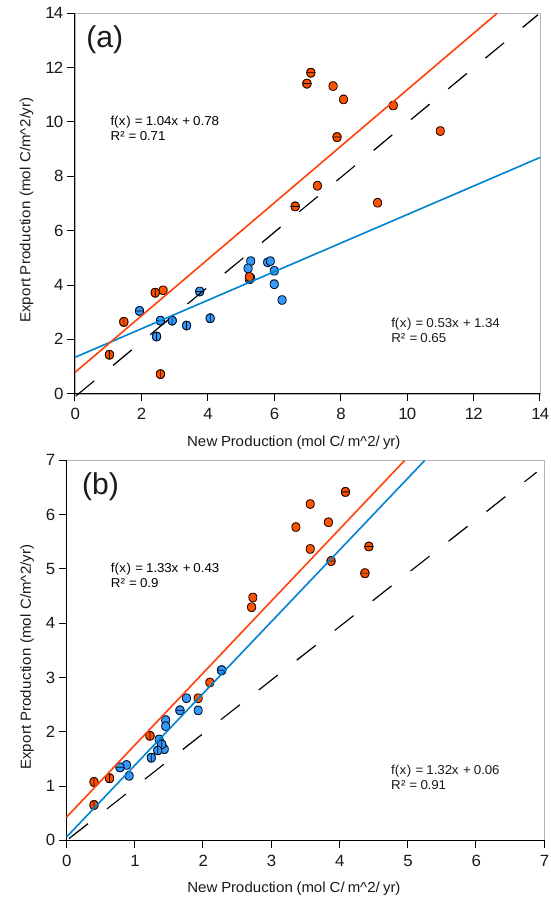
Fig. 13. Export production as a function of new production in the California CS (blue) and Canary CS (orange) averaged (a) over the 300km wide nearshore area and (b) between 300km and 500km offshore. Data were averaged over 1 ◦ bins in meridional direction. Circles with horizontal lines correspond to the southernmost part of each system, i.e., from 30 ◦ N to 34 ◦ N for the California CS and from 12 ◦ N to 16 ◦ N for the Canary CS, and circles with vertical lines indicate their northernmost parts, i.e., from 42 ◦ N to 46 ◦ N for the California CS and from 24 ◦ N to 28 ◦ N for the Canary CS. The diagonal dashed grey line indicate the identity